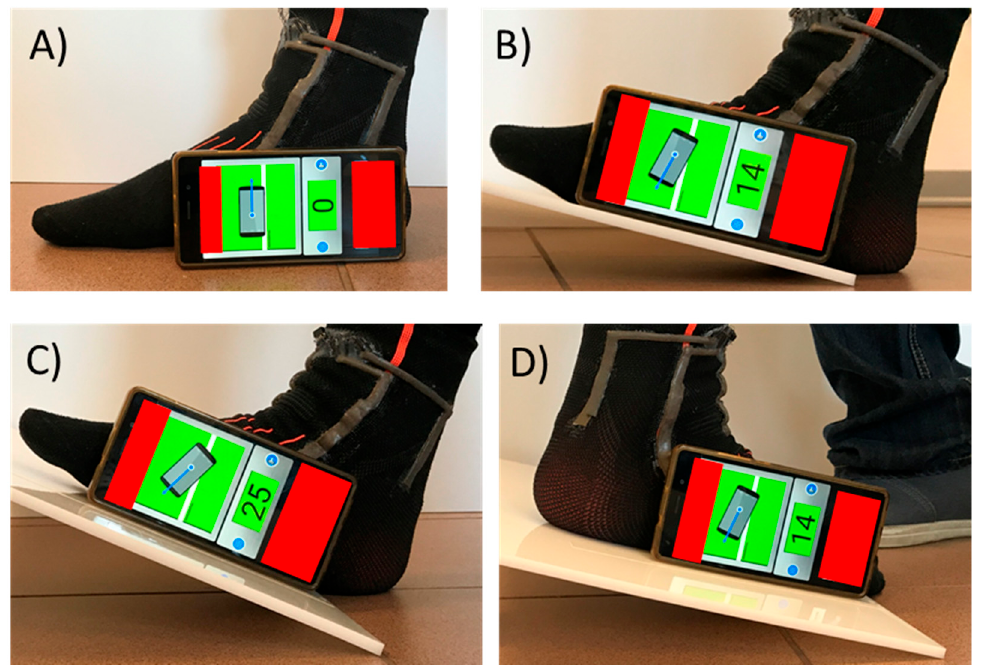
Figure 17. Example of possible calibration procedure for anklet using a smartphone and a customized